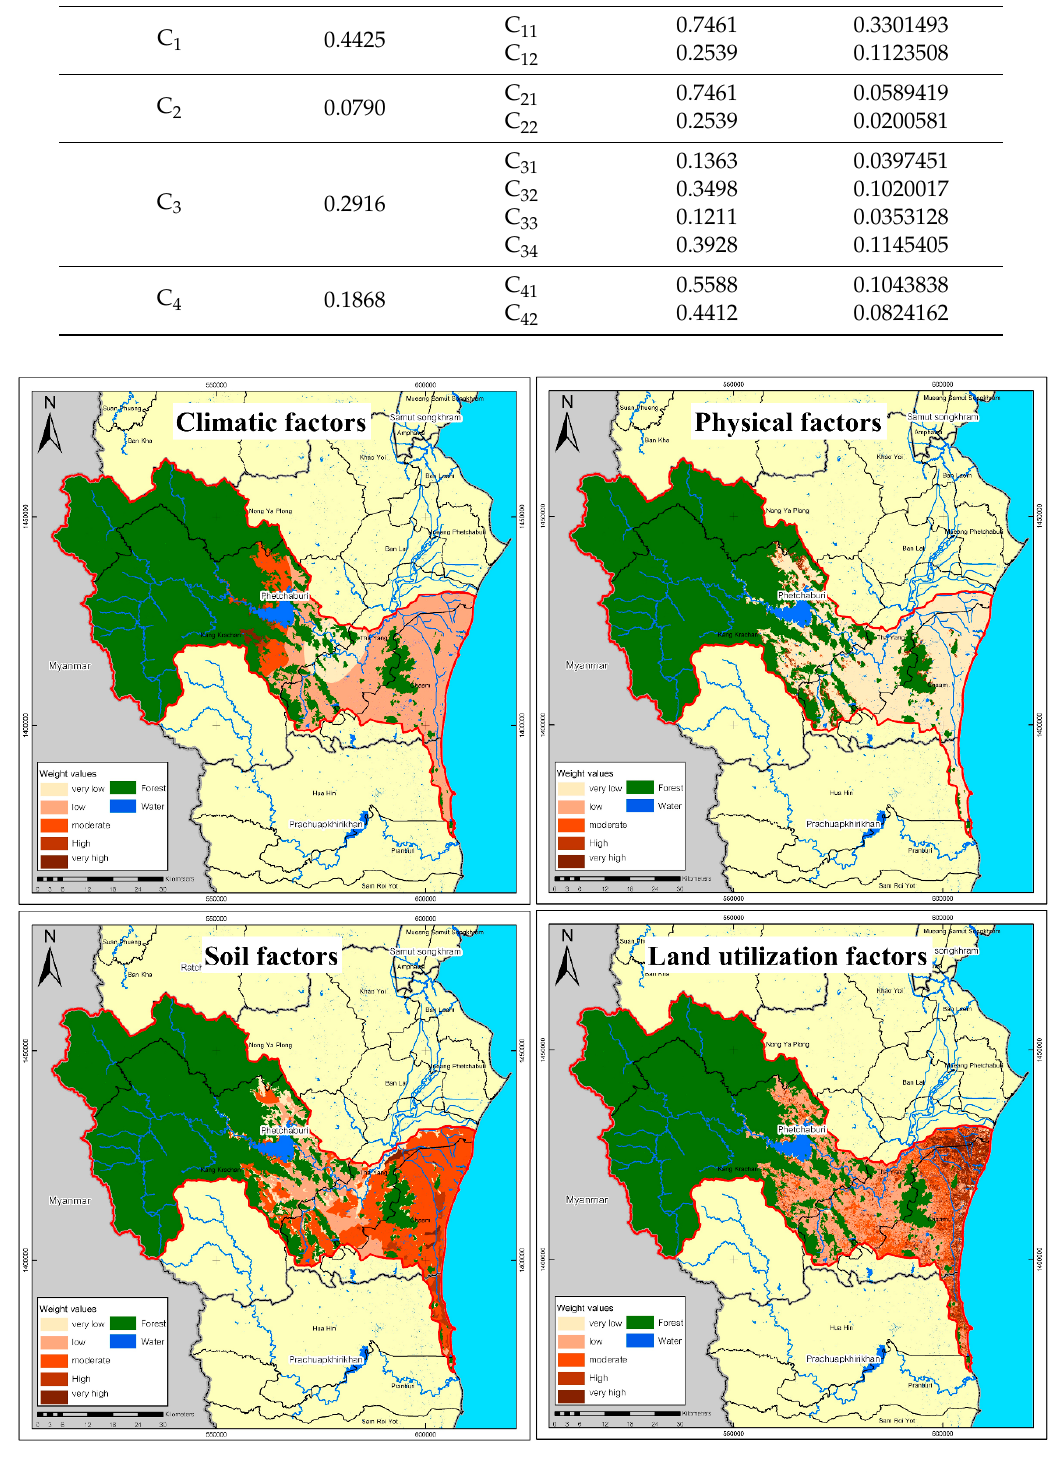
Figure 3. The weighted values of drought risk factor of UPRB .